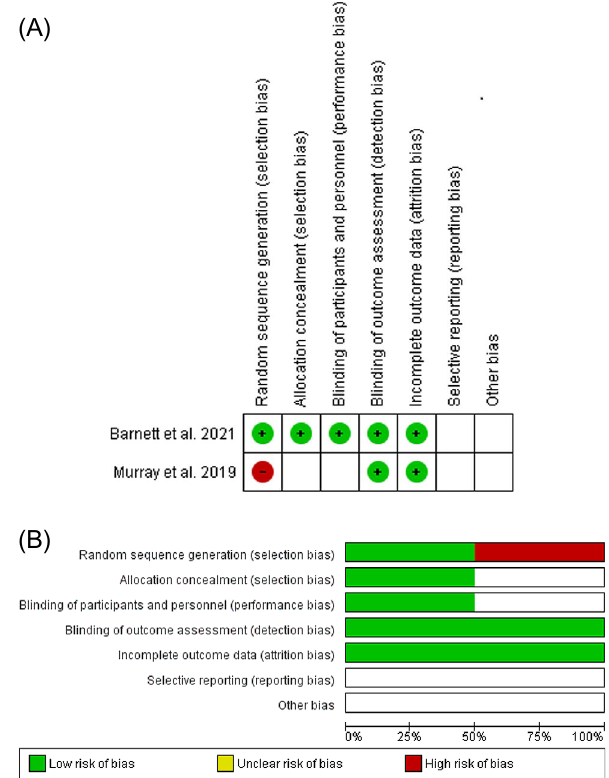
Figure 2. (A) Risk of bias item for each included study. (B) Risk of bias item presented as percentages across all included